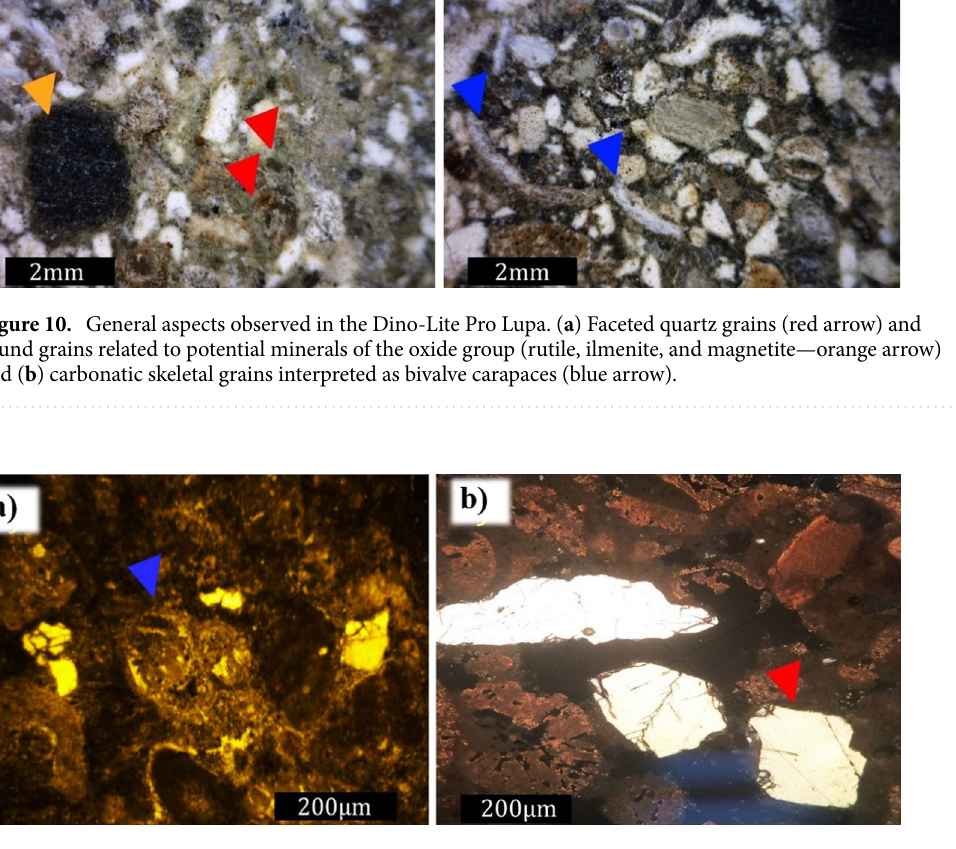
Figure 11. Synthetic carbonate rock observed under the petrographic microscope. Detail of green algae fragment Halimeda (lower blue arrow) and a bivalve carapace (upper blue arrow). Quartz grain (red set) and (b) quartz grains in a pore region (black region, red